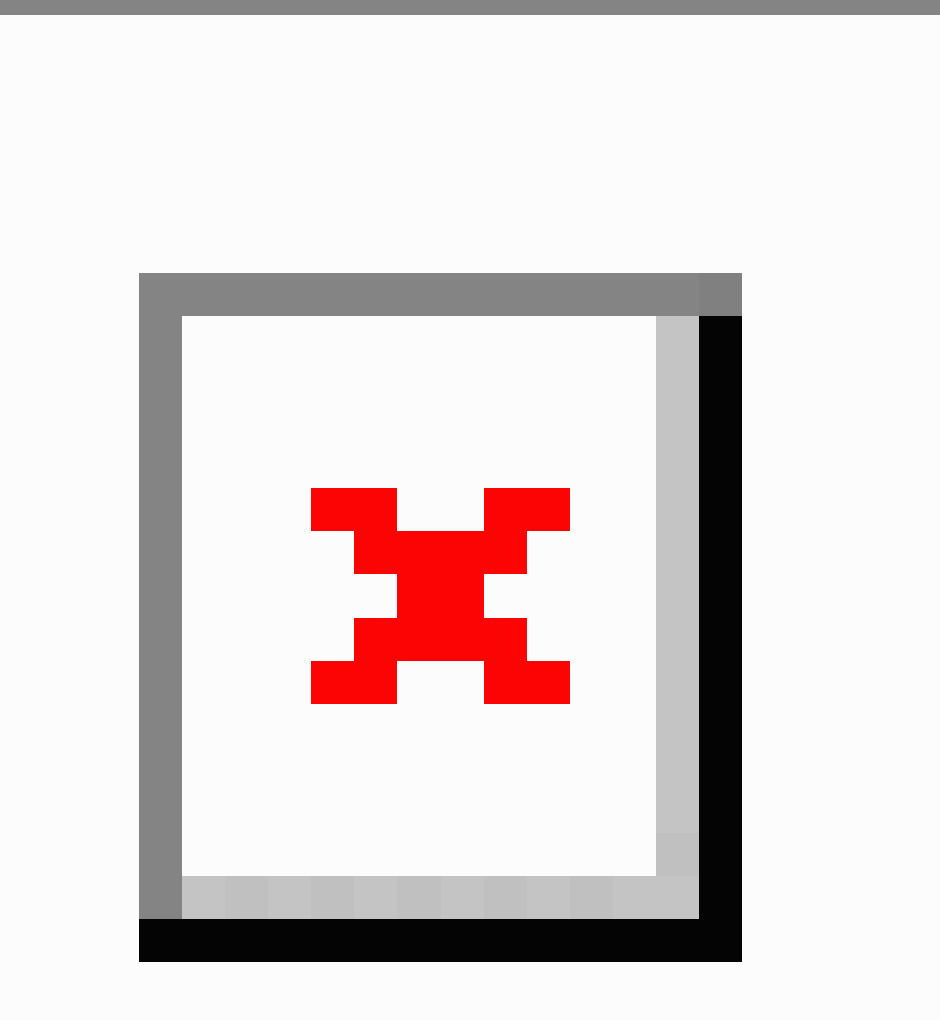
Figure 6. All basic scenarios scored consistently well regarding ease of completion (blue) with just slight superficial changes, the more challenging scenarios such as login and reset registered higher (worse) scores. Only one scenario, connection routine, scored poorly in the time taken (red) metric, owing to the length of time it takes the insoles to sync with the app. Several experts were confused by some of the layout and instructions in the manuals (green), with improvement required for several scenarios, particularly the instructions for the fall alarm